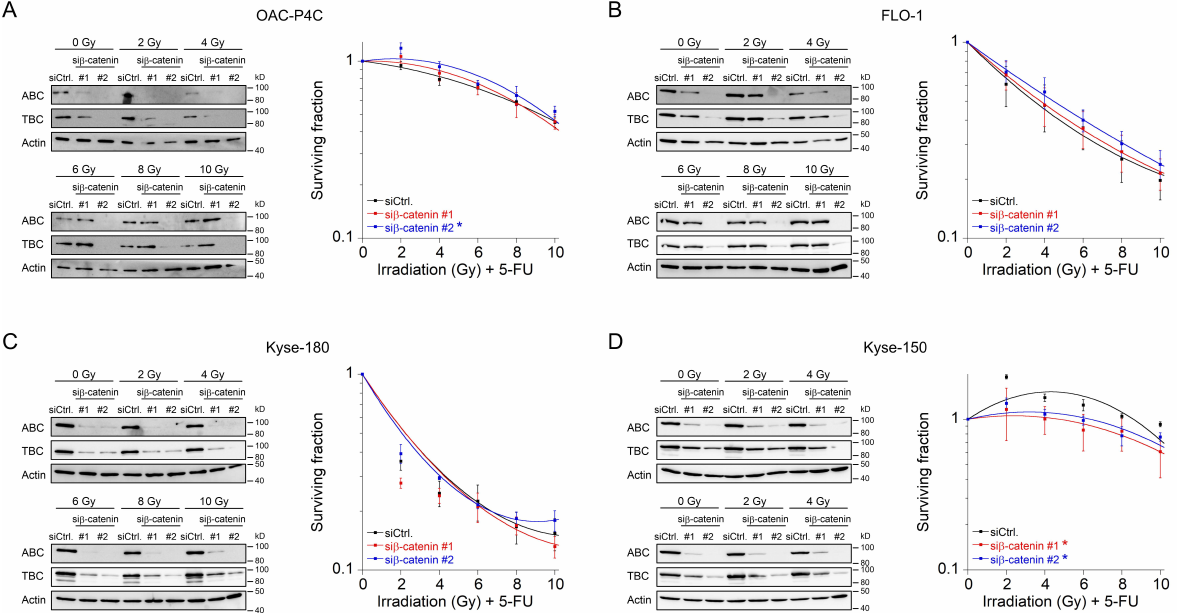
Figure 3. Survival analyses of basal Wnt/ β -catenin signaling inactive cells in a fractionated irradiation experimental design. ( A – D ) Cell lines OAC-P4C ( A ), FLO-1 ( B ), Kyse-180 ( C ), or Kyse-150 ( D ) were transfected with a control siRNA (siCtrl.), or with siRNA targeting β -catenin (si β -catenin #1, #2), and subjected to immunoblot analyses (left), or monitored for CFA survival after CRT as fractionated irradiation in doses of 2 Gy every twelve hours (right). Data presented as mean ± s.e.m. from at least n = 3 independent biological replicates. * p < 0.05, two-way analysis of variance (ANOVA). For p -values see Table